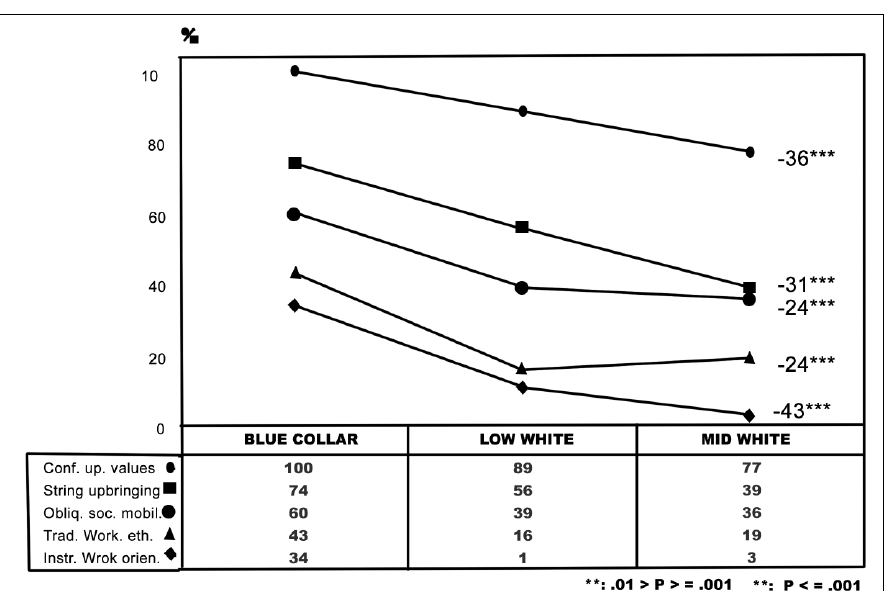
Difference between the three occupational groups on the socio- cultural scales, in